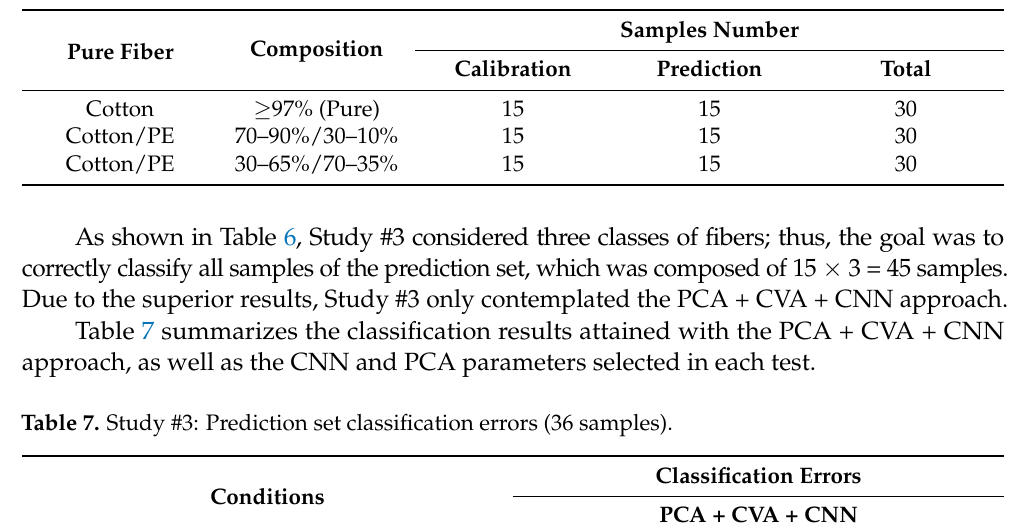
Table 6. Study #3: Pure cotton and cotton/PE mixtures.